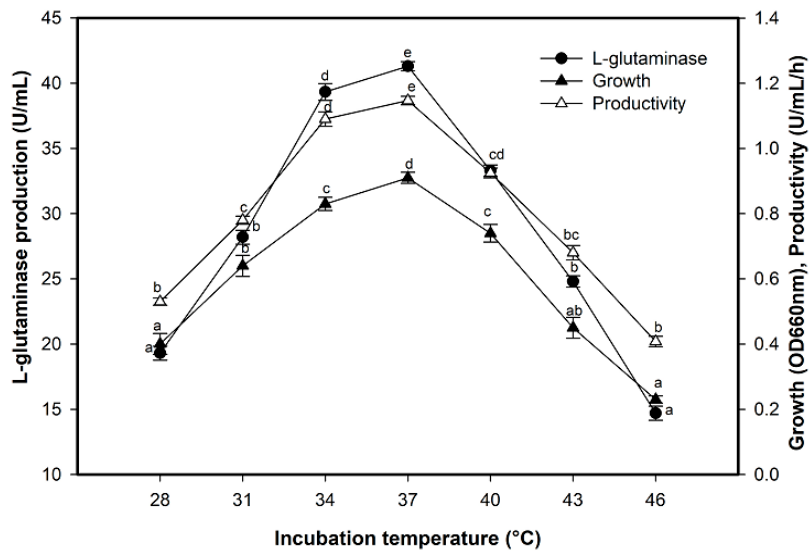
Figure 5. Effect of incubation temperature on L-glutaminase production. Mean ± standard error ( n